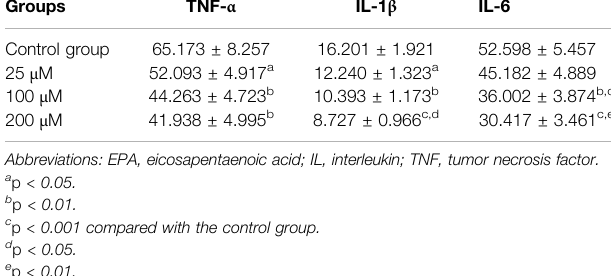
TABLE 1 | Wogonin inhibition of the expression of tumor necrosis factor alpha, interleukin-1 β , and interleukin-6 in the U251 cells.